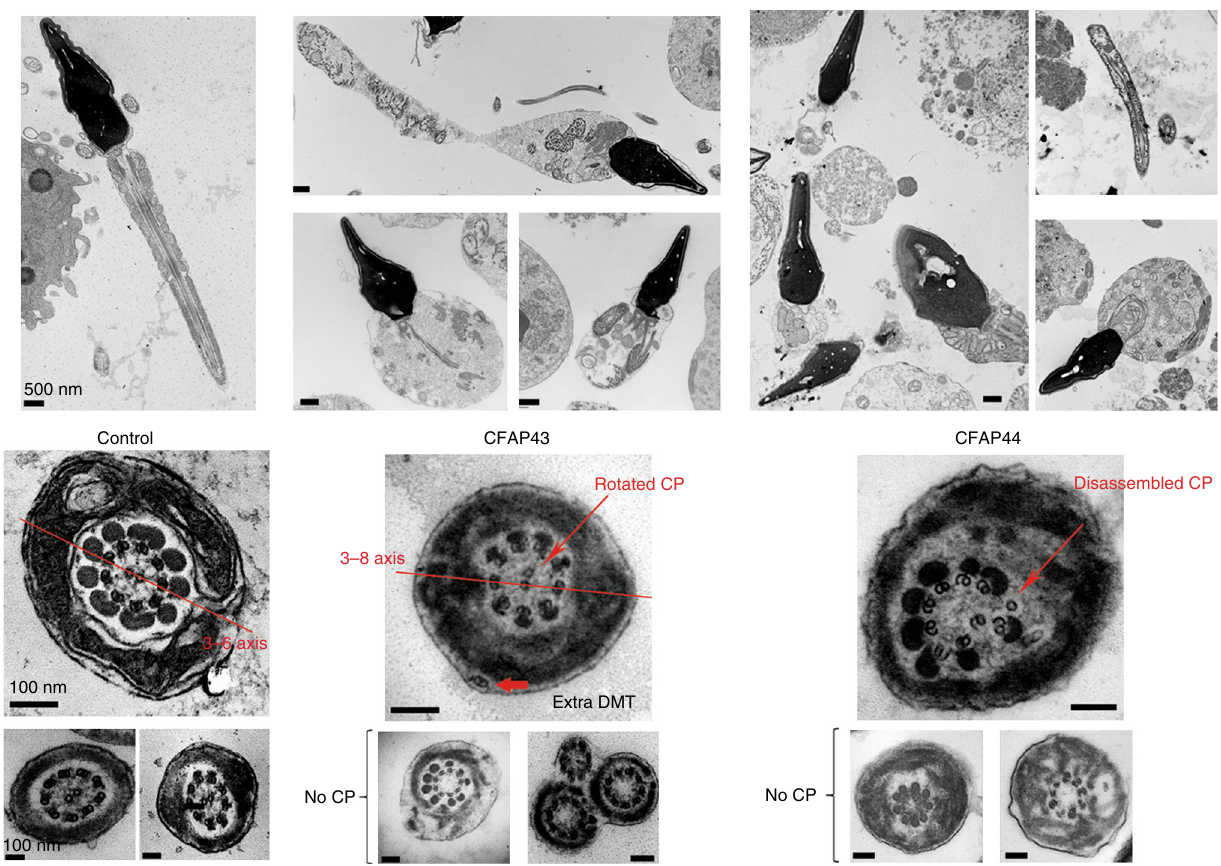
Fig. 2 Transmission electron microscopy analysis of sperm cells from CFAP43 and CFAP44 patients shows a severe axonemal disorganization. (Left panel) Longitudinal sections (scale bar = 500 nm) and cross-sections (scale bars, 100 nm) of sperm fl agellum from control. (Central panel) Longitudinal sections (scale bars, 500 nm) and cross-sections (scale bars, 100 nm) of sperm fl agellum from CFAP43 -mutated patient (P 43 -8). We can notice a short tail corresponding to a cytoplasmic mass containing the different components of the fl agellum, all unorganized. In CFAP43 upper cross-section, the CPC is not aligned with DMTs 3 and 8 (red line) and is rotated by 90°. We can observe the absence of central pair of microtubules in other cross-sections. (Right panel) Ultrastructure of CFAP44 -mutated sperm (P 44 -3) longitudinal sections (scale bars = 500 nm) show similar ultrastructure of short tail (cytoplasmic mass). In CFAP44 upper cross-section, the central pair is disassembled and displaced (red arrow). We can observe the absence of central pair of microtubules in other cross-sections. Scales bars for cross-sections = 100